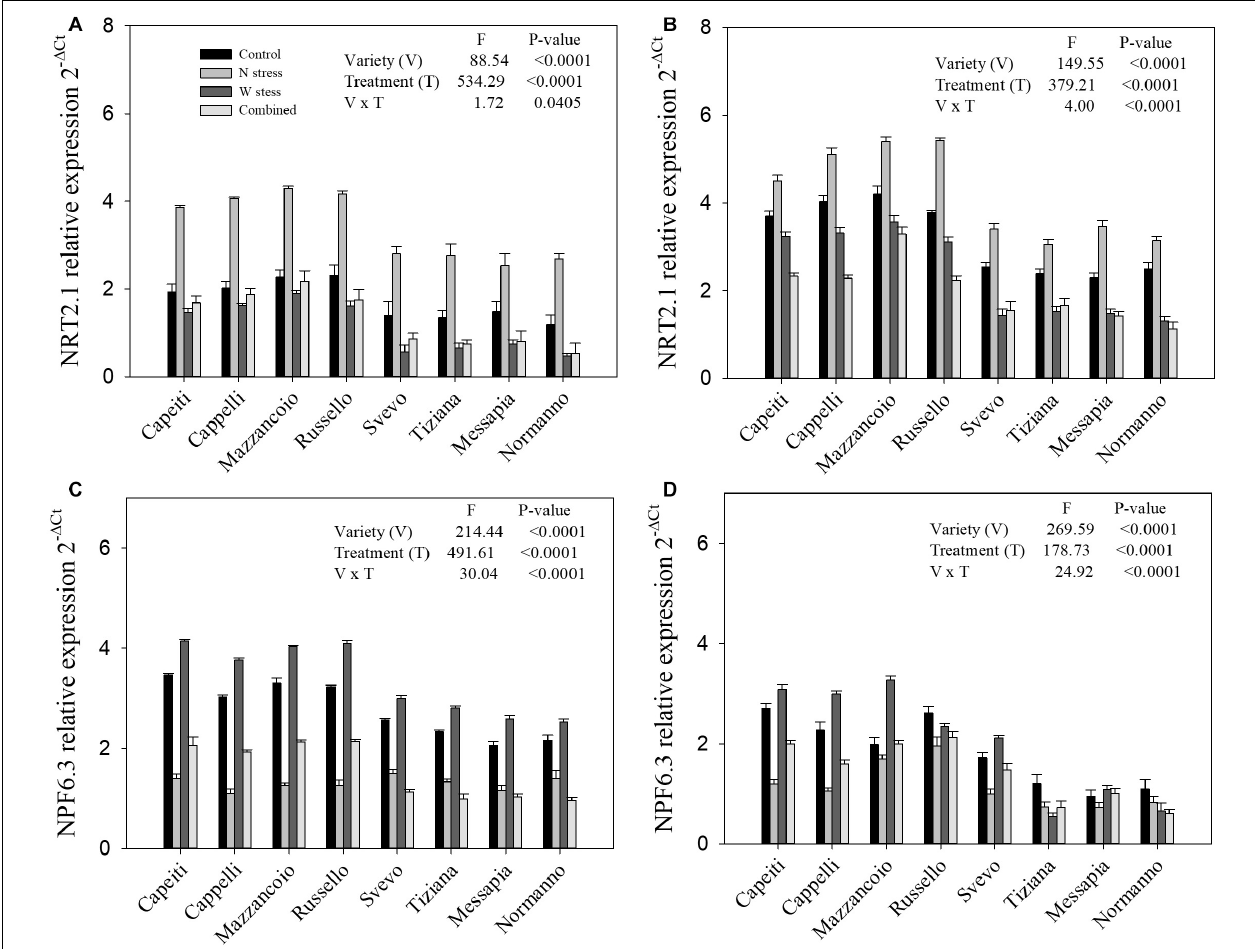
FIGURE 8 | Expression of genes relative to nitrate transporter in durum wheat root. NRT2.1 and NPF6.3 relative expression at stem elongation (A,C) and milk ripening (B,D) are